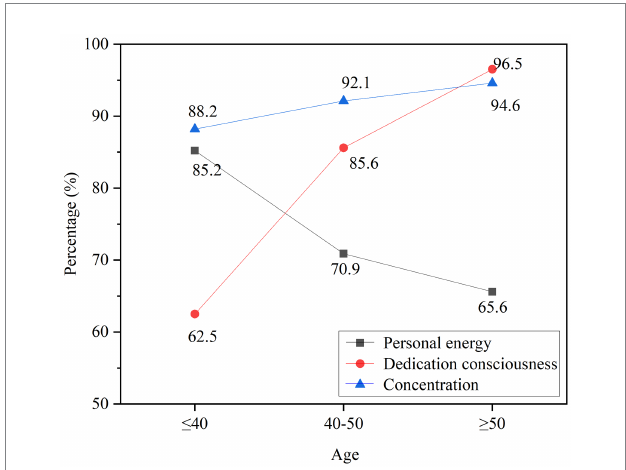
FIGURE 11 The influence of psychological emotions on teachers’ psychological state.